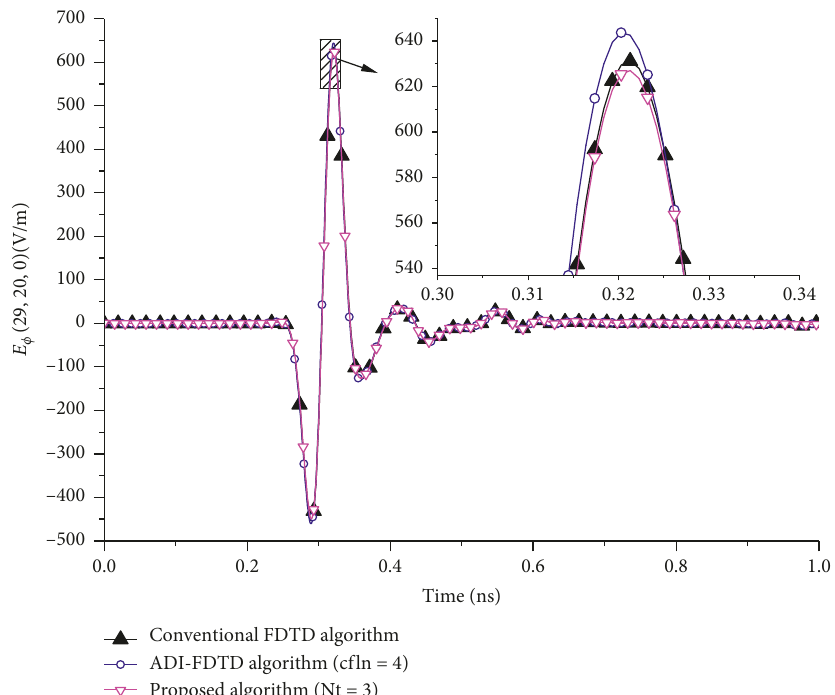
Figure 13: Computational results of E